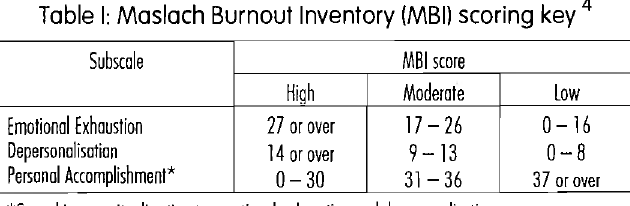
Table 1: Maslach Burnout Inventory (MBI) scoring key 4